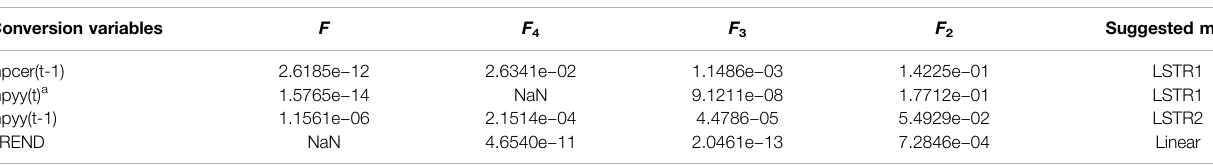
TABLE 2 | Nonlinear test results.